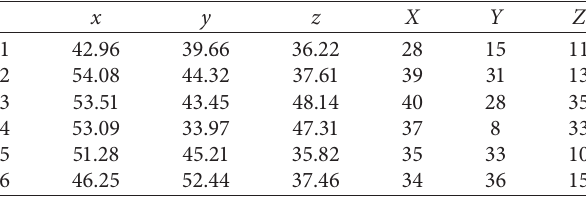
Table 2: Object coordinate statistics of bridge pier measurement